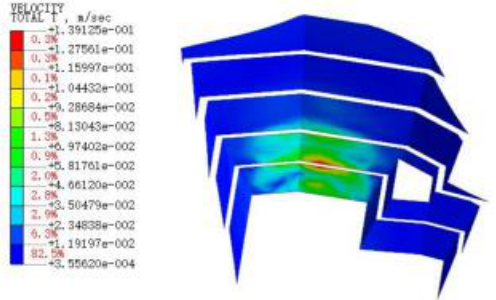
Figure 17. The vibration velocities of retaining walls at 200 ms.